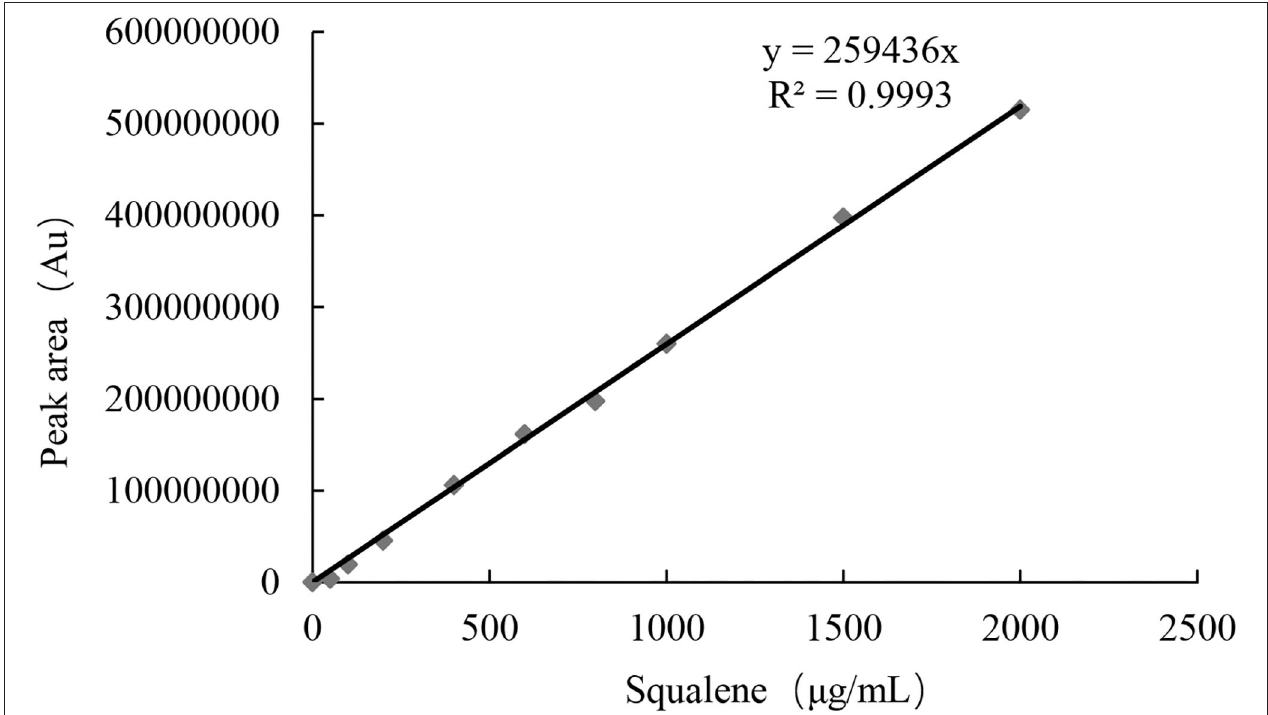
FIGURE 3 | Linear regressive relationship between squalene concentration and peak area.